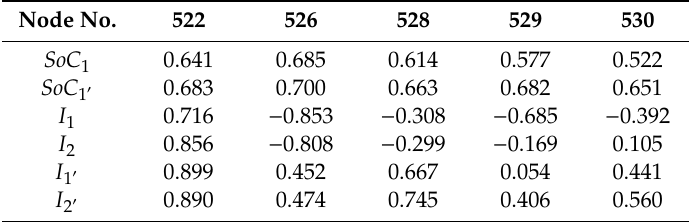
Table 3. Controller parameters for the individual ESU (load profile A).